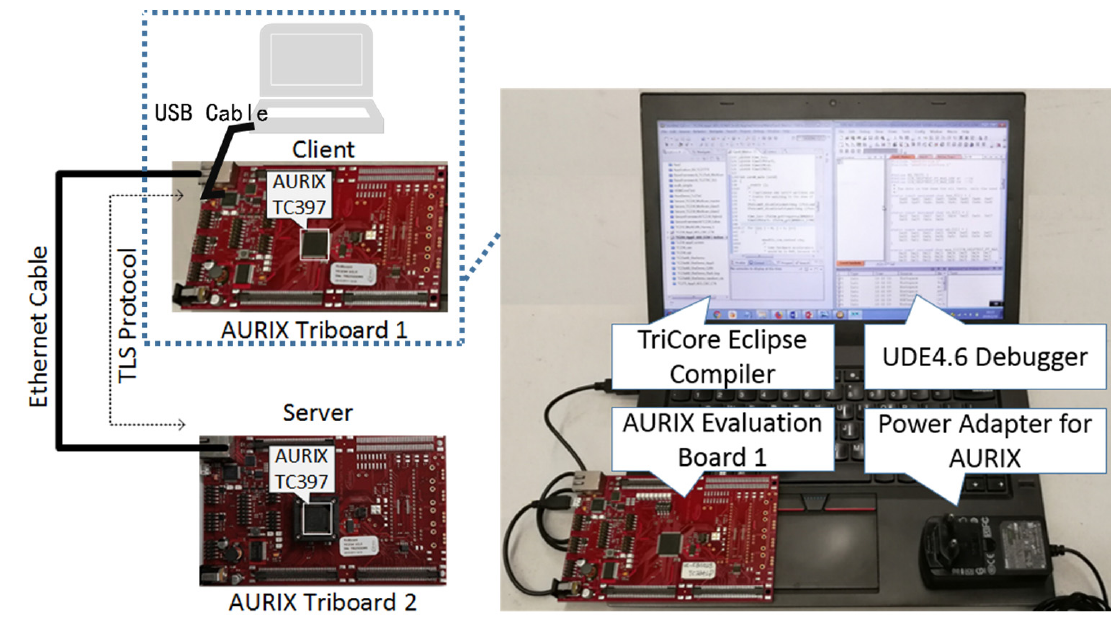
Figure 4. Experiment equipment and software.